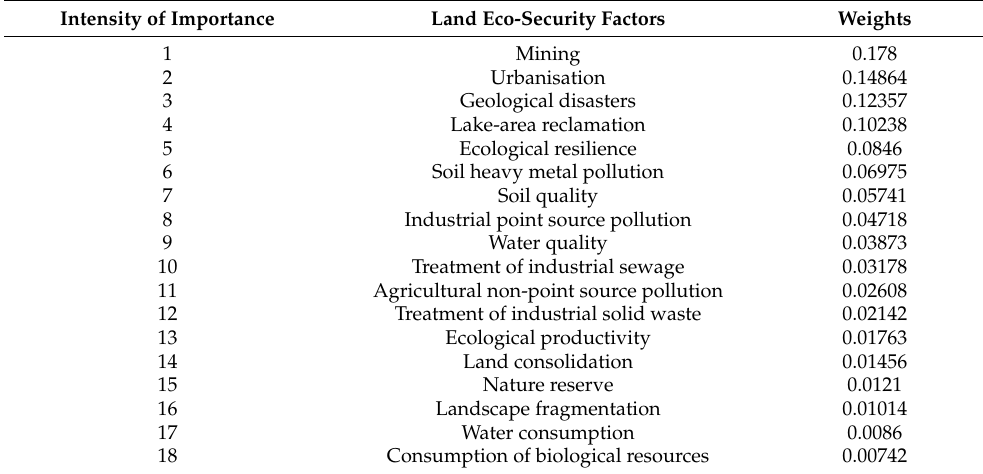
Table 2. Weight design of risk sources in the Daye